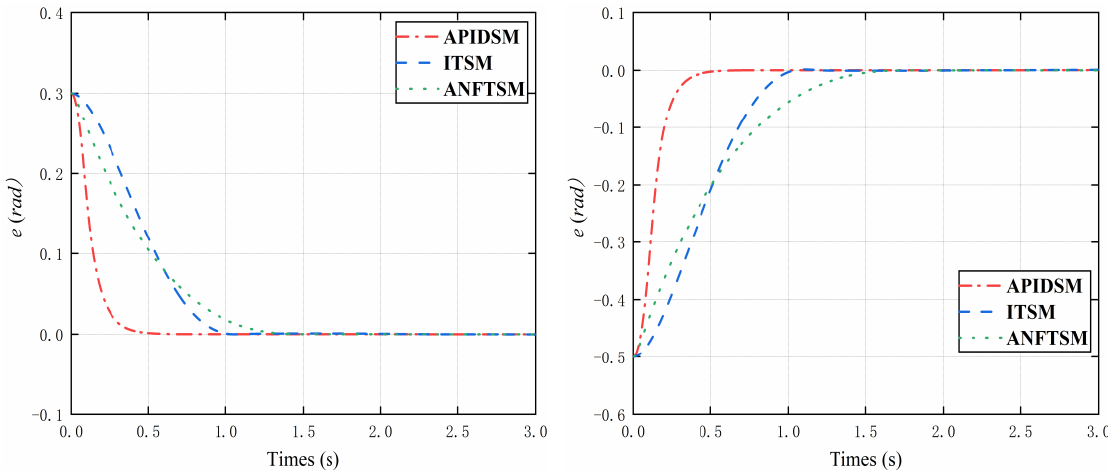
Figure 12. Comparison of position tracking error results between controllers of Joint 1 and Joint 2.